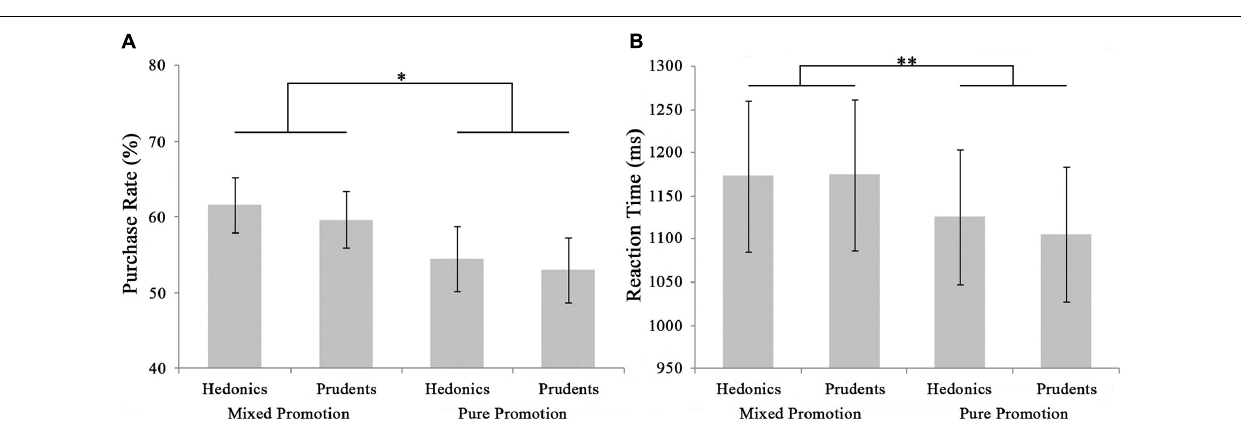
FIGURE 2 | Behavioral results. The purchase rate (A) and reaction time (B) for every condition, and the purchase rate of each discount amount in the mixed promotion and pure promotion conditions, respectively. The error bars suggest standard error of the mean. ∗ p < 0.05, ∗∗ p <